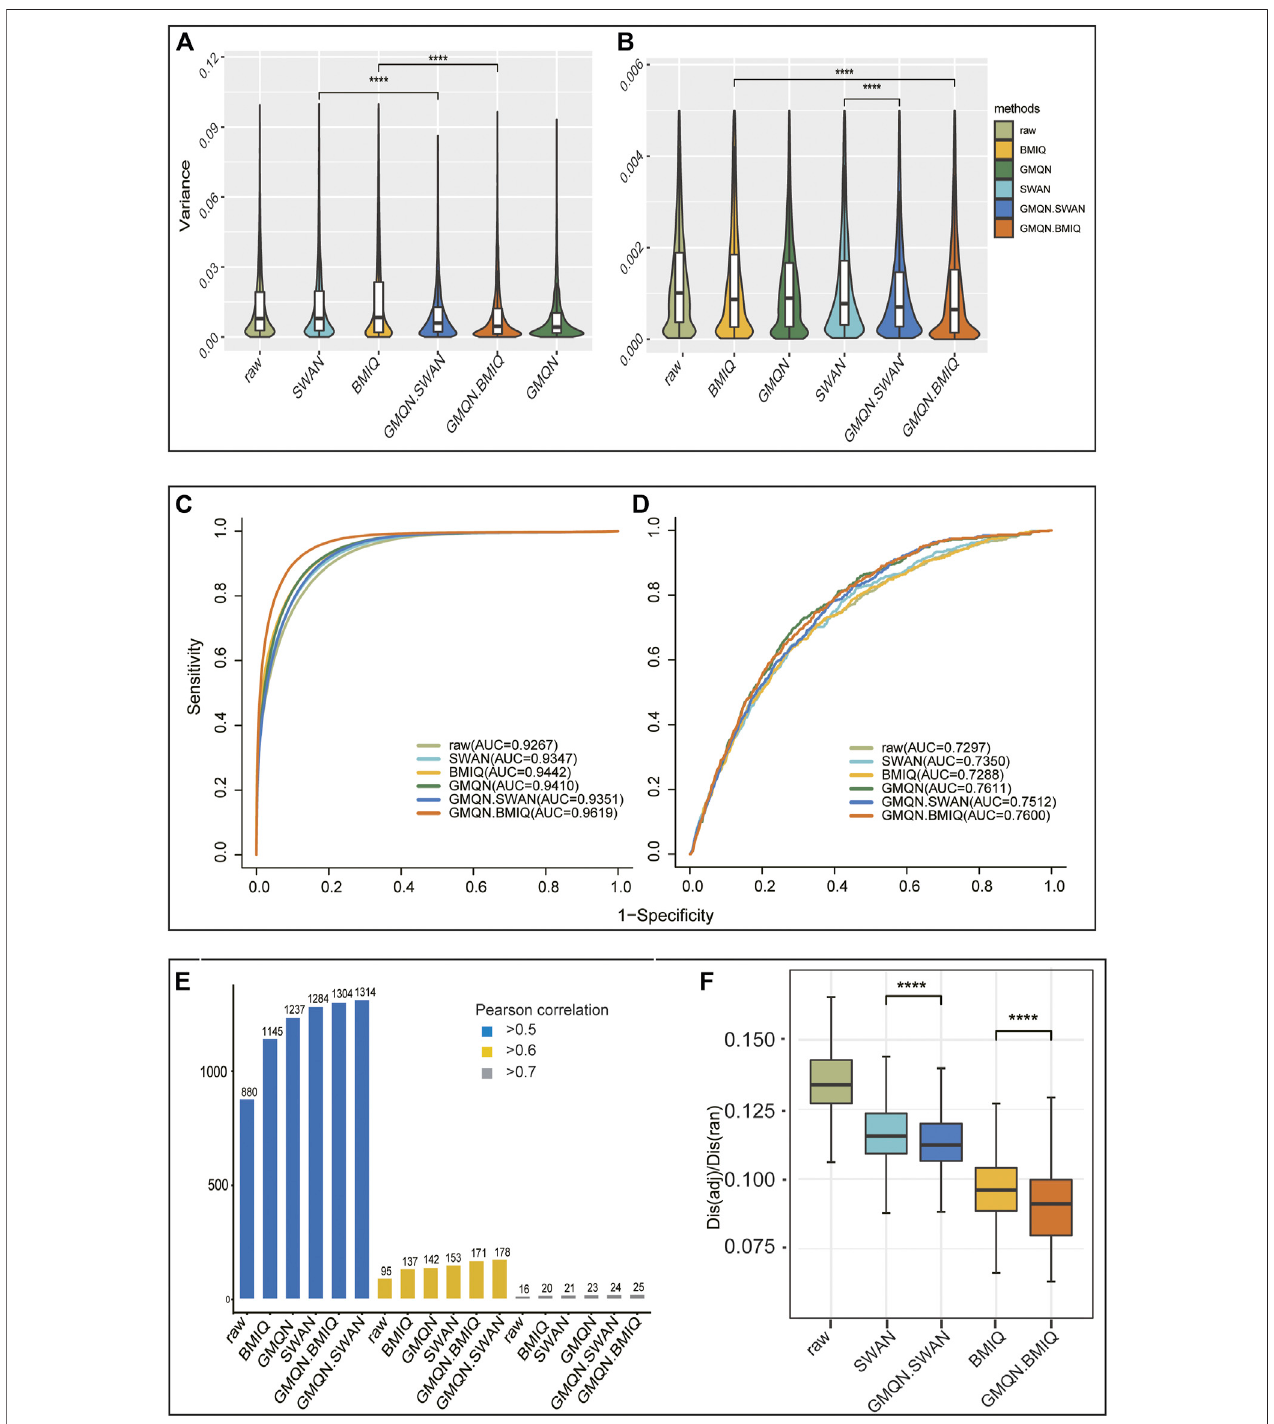
FIGURE 4 | The result of Benchmark Test. (A) and (B) : batch effects detection. (C) and (D) : case-control study. (E) : regression analysis. (F) : comparison of the methylation levels of adjacent CpG sites (**** p < 10-4, **** p < 10-4)